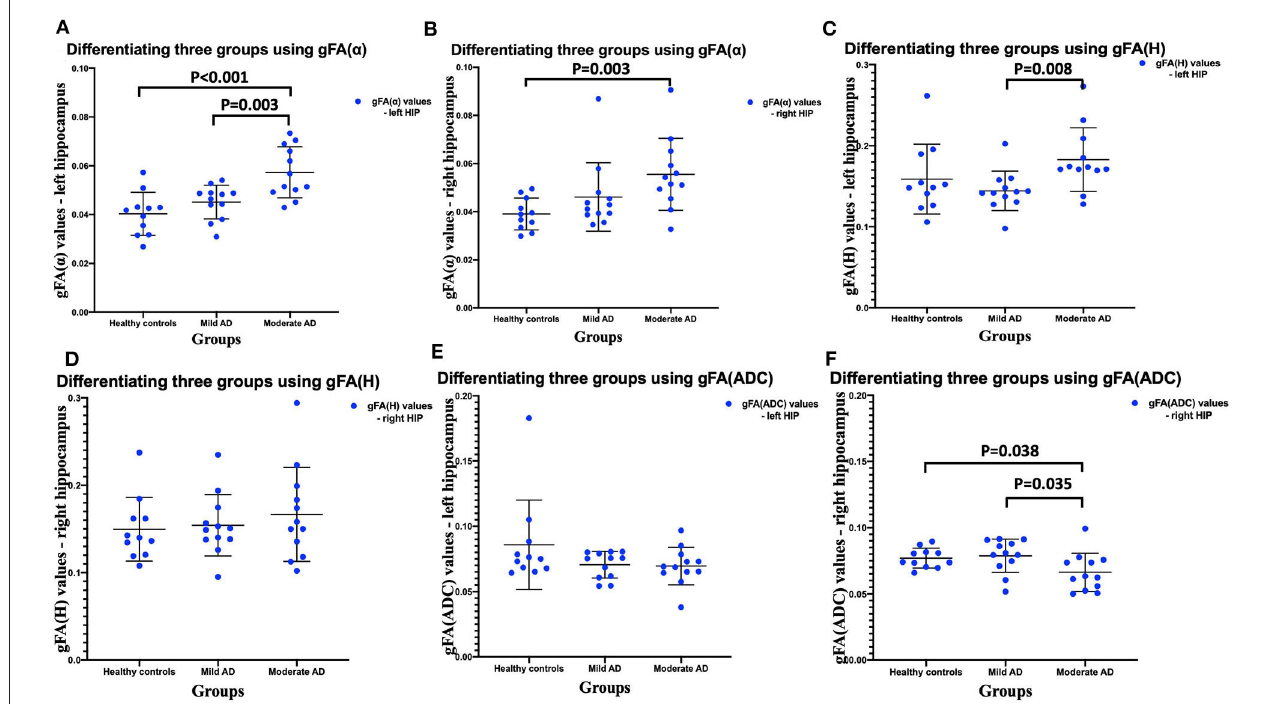
FIGURE 4 | Comparisons among three groups: healthy control group, mild AD patient group, and moderate AD patient group (A–F) . Scatter plots show that gFA( α ) and gFA( H ) of the left hippocampus (A,C) , and gFA(ADC) values of the right hippocampus (F) can readily separate the mild AD patients and moderate AD patients, and gFA( α ) of the bilateral hippocampus (A,B) , gFA(ADC) values of right hippocampus (F) can easily distinguish the moderate AD patients and healthy controls. n = 12 for mild AD patients, n = 12 for moderate AD patients, and n = 11 for healthy controls. P < 0.05 was considered as significant. AD, Alzheimer’s disease; gFA, generalized fractional anisotropy; ADC, apparent diffusion